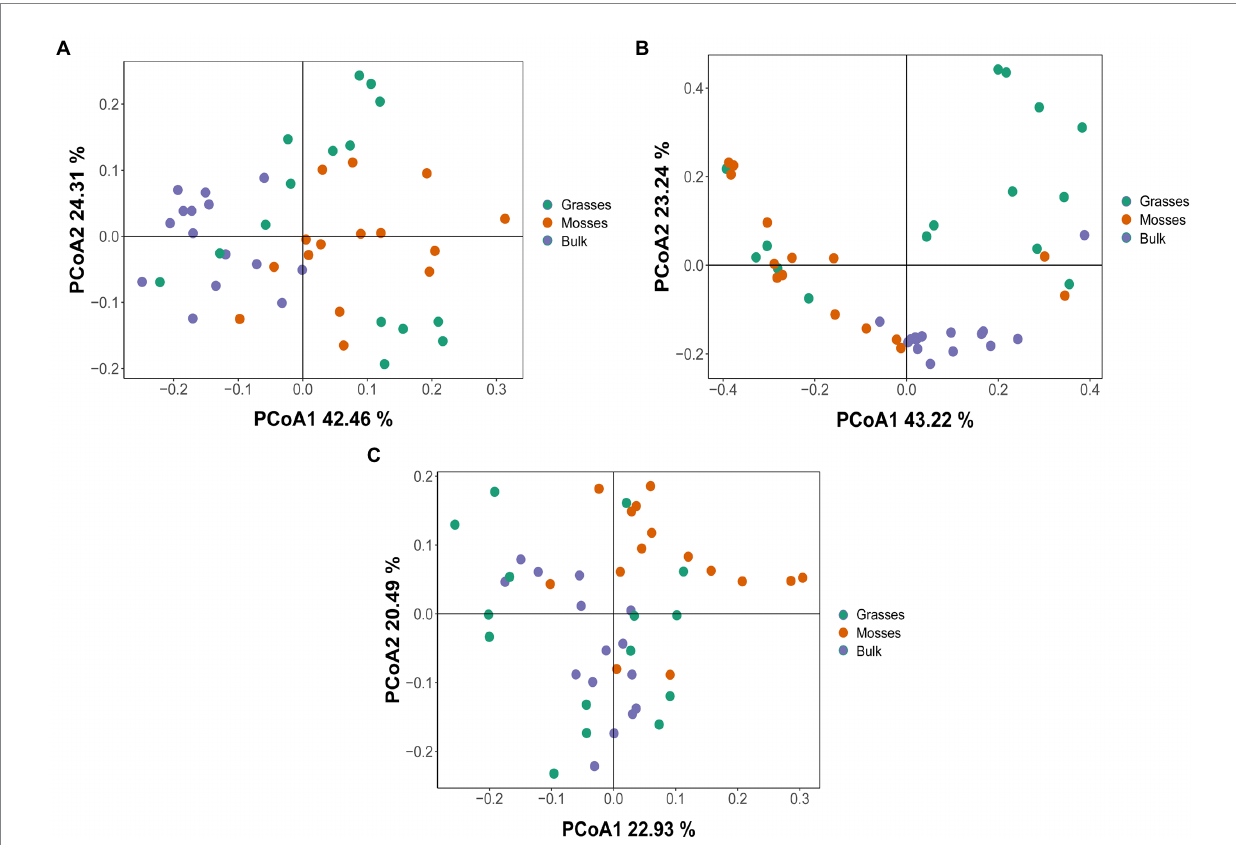
FIGURE 2 PCoA (Principal coordinate analysis) with Bray–Curtis dissimilarity to quantify compositional differences between samples based on bacterial OTUs at the genus level. PCoA1 (Axis 1) and PCoA2 (Axis 2) respectively explain the dissimilarity between samples (A) Actinobacteria (42.46 and 24.31%),